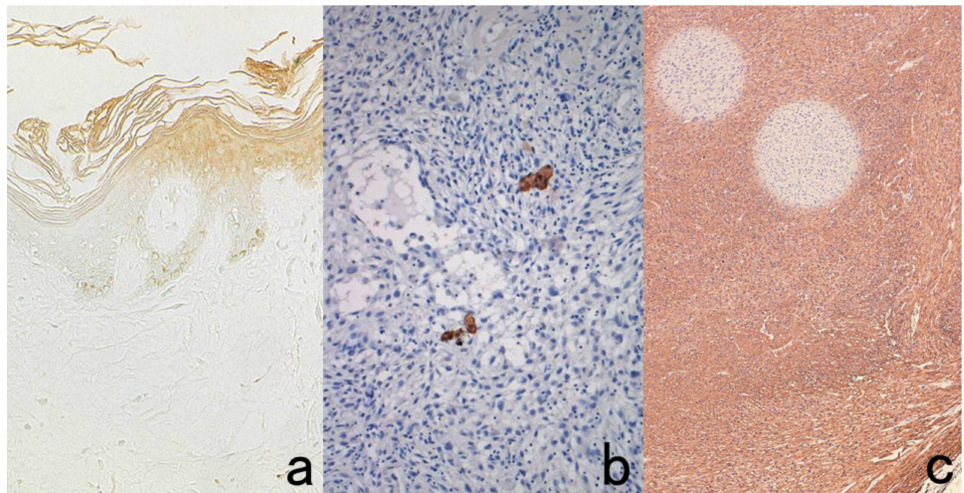
Figure 23. Technical artifacts. Effects of drying. ( a ): surfactant apoprotein immunostaining for the skin, contamination of cytokeratin-positive scales. ( b ): cytokeratin immunostaining for spindle cell sarcoma and insufficient deparaffinization. ( c ): smooth muscle actin immunostaining for leiomyosar- coma. Drying of sections during antibody incubation causes nonspecific binding in the dried area ( a ). Contaminated cytokeratin-positive scales on the section should be distinguished from true positivity ( b ). False-negative rounded areas result from insufficient deparaffinization. ( c